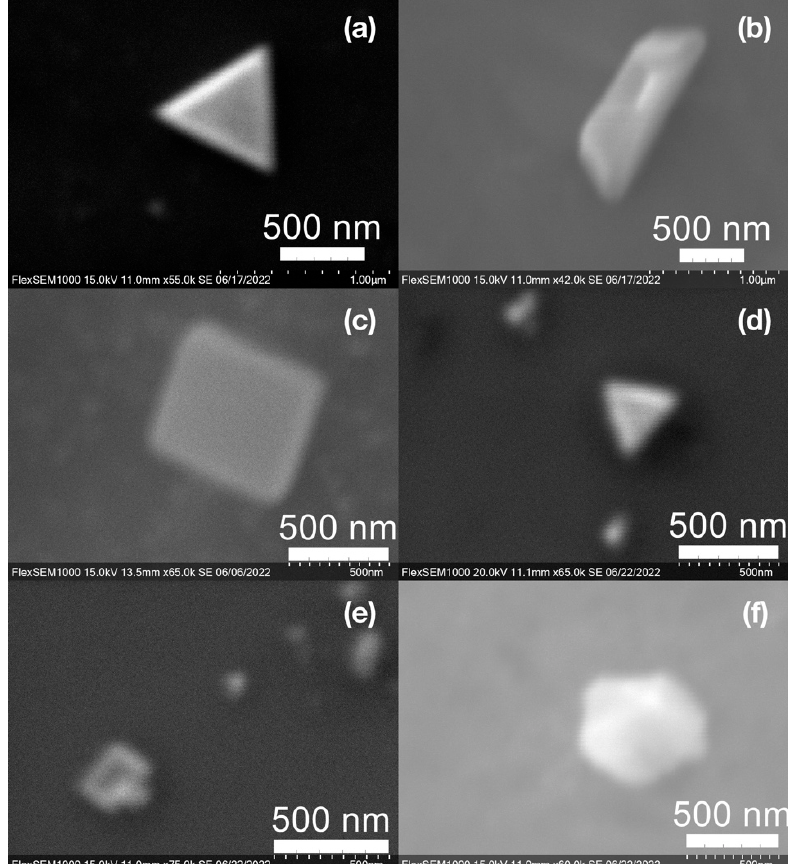
Figure 11. Various gold (Au) nanoparticle shapes synthesized using spent coffee grounds of ( a – c ) dark roast used in espresso (SDE), and ( d – f ) medium roast used in cold brew coffee (SMC).